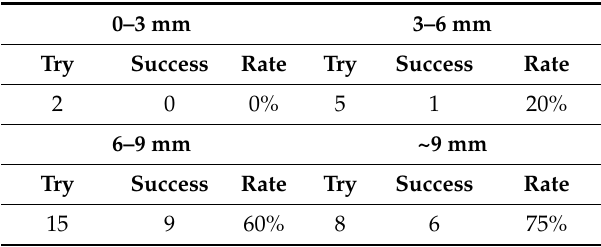
Table 3. Field experiment results of harvesting algorithm according to length of